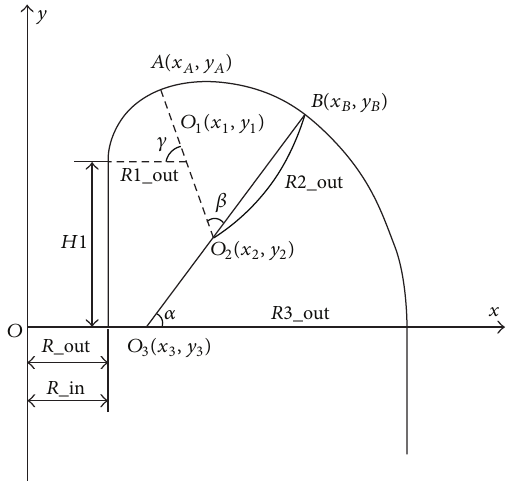
Figure 5: Geometric elements of upper half cross section of VV.